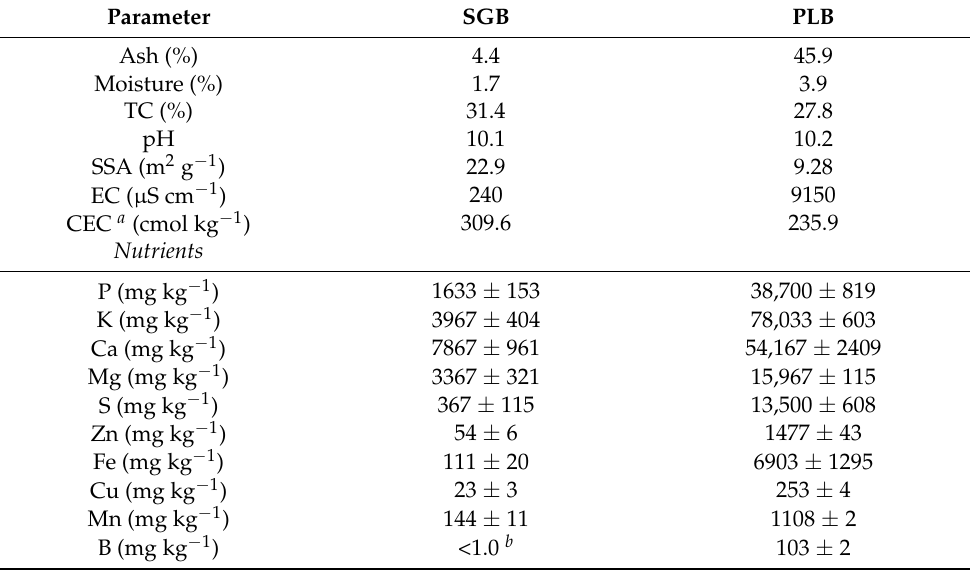
Table 1. Main physicochemical properties of biochars used in the study (adapted from [18]).